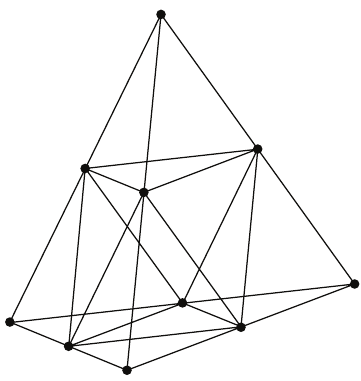
Figure 1: The first approximating graph Γ 1 for the fractal P 4 .